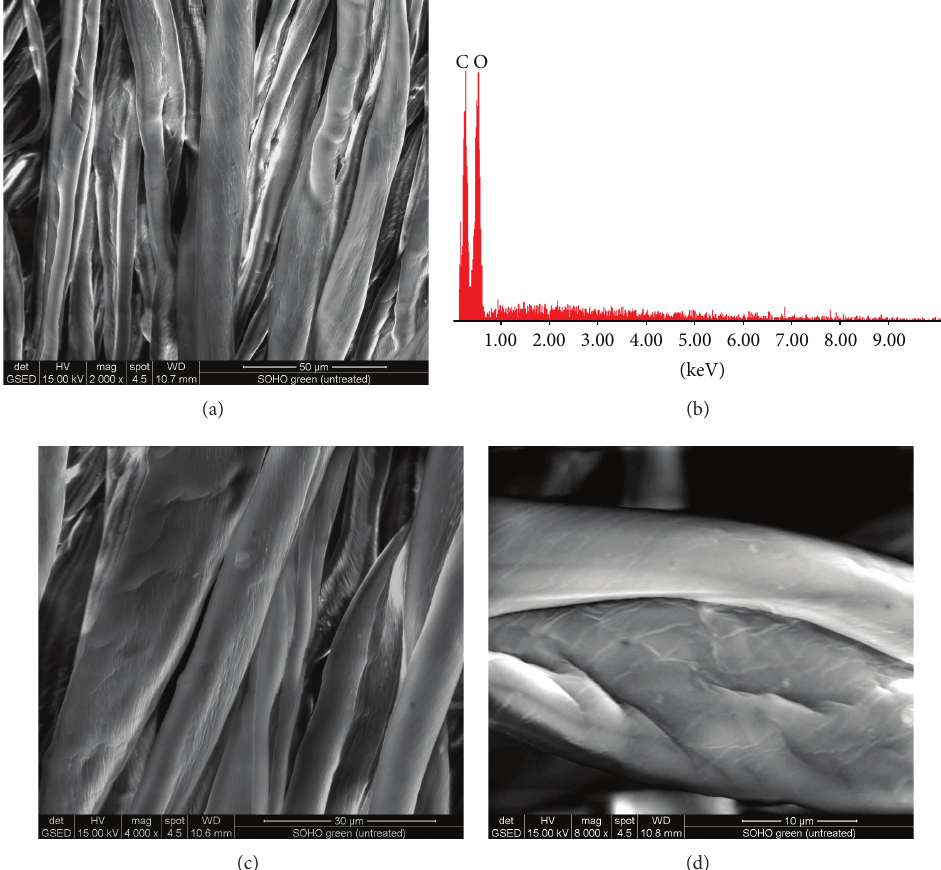
Figure 4: SEM and EDAX images for sample Ig (control) (plasma functionalized type I green cotton 100%): (a) SEM image for sample Ig at resolution × 2000, (b) EDAX image for sample Ig, (c) SEM image for sample Ig at resolution × 4000, and (d) SEM image for sample Ig at resolution × 8000.